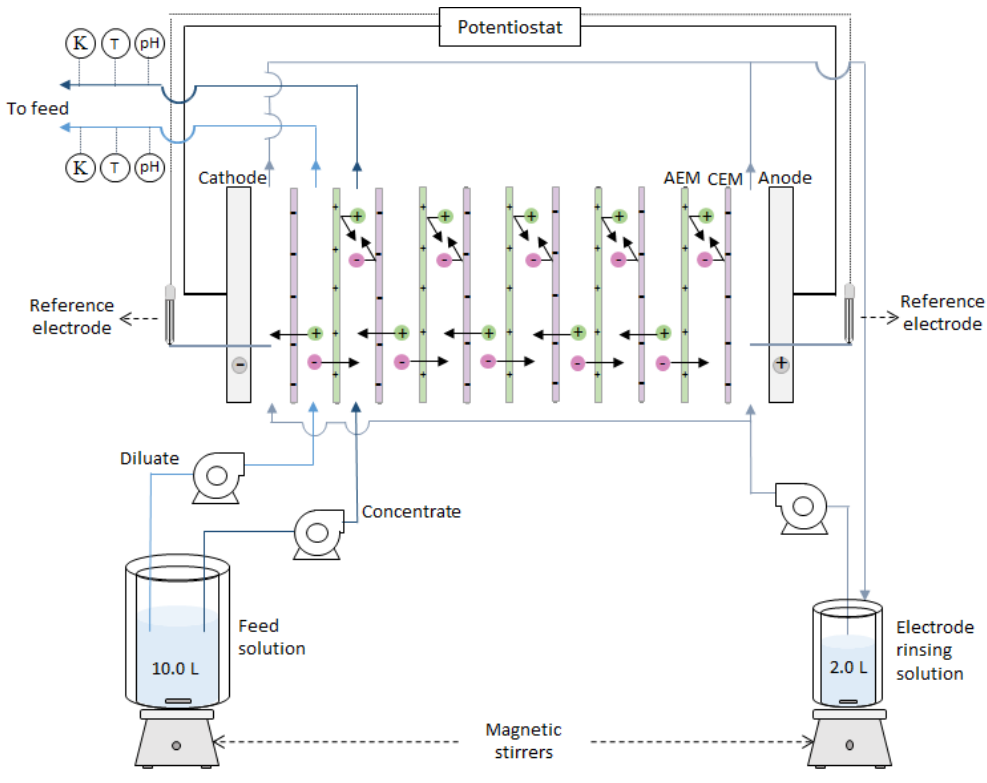
Figure 1. Scheme of the setup employed. The experiments were run in a batch recirculation mode, in which two streams were taken from the same feed solution, circulated through the ED-stack, and returned to the same reservoir. Adapted from [6]. Table 3. Feed compositions, current density, flow rate, velocity, and times of the different experimental stages.